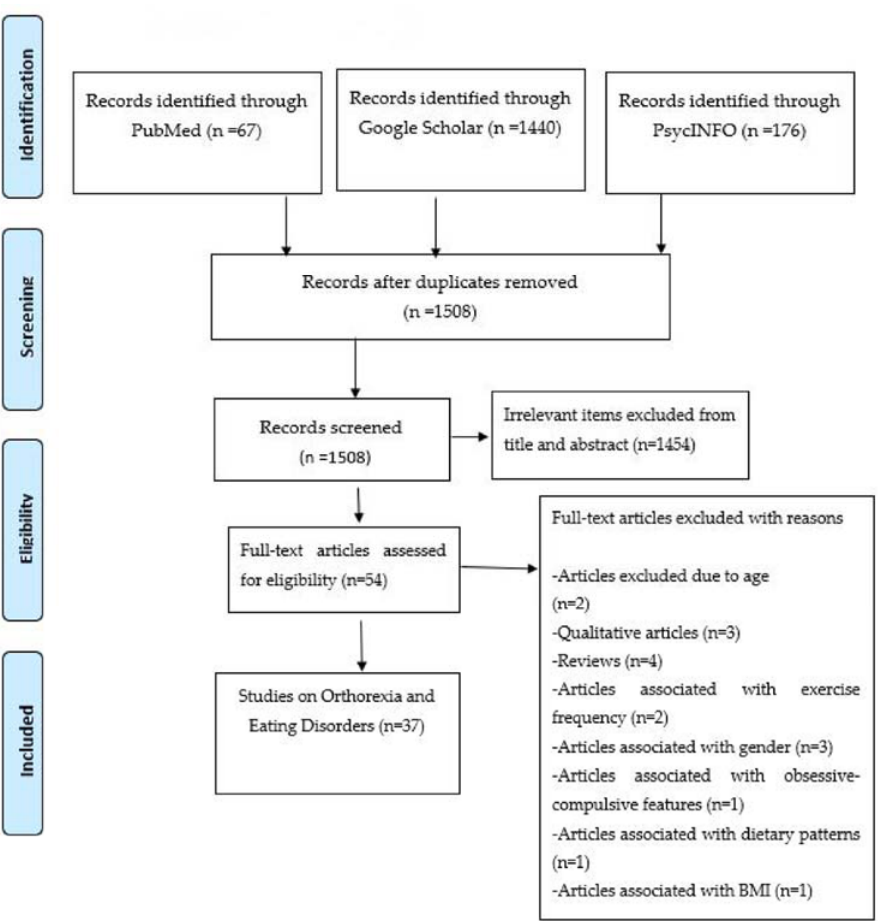
Figure 1. PRISMA flow diagram—selection of studies.